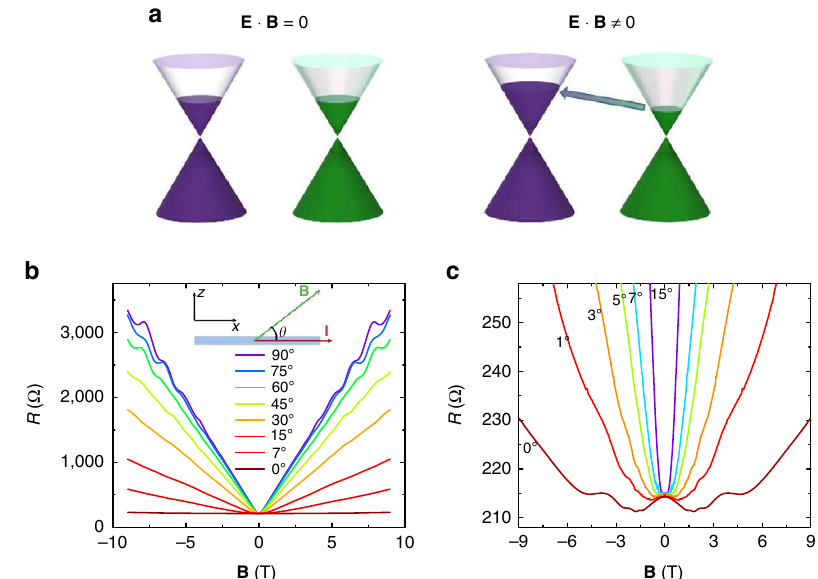
Figure 1 | Illustration of the charge pumping process and the angle-dependent MR in the Cd 3 As 2 nanoplates. ( a ) Charge pumped from one Weyl node to the other in the presence of chiral gauge fields. This pumping process is also applied to Dirac semimetals, whose nodes are degenerated but distinguished by isospin. ( b ) The angle-dependent MR curves of sample N1. The inset is the schematic view of the transport measurement setup, showing B rotating in the x - z plane. Here, y is defined as the angle between B and I . For a large y , the sample exhibits a positive B -linear MR. ( c ) An enlarged view of MR of sample N1 as y approaches zero. MR decreases rapidly as y approaches zero. When y is near zero, a clear dip was observed in the (cid:3) 2 B 2Trange, followed by an upturn of MR in the larger fields.